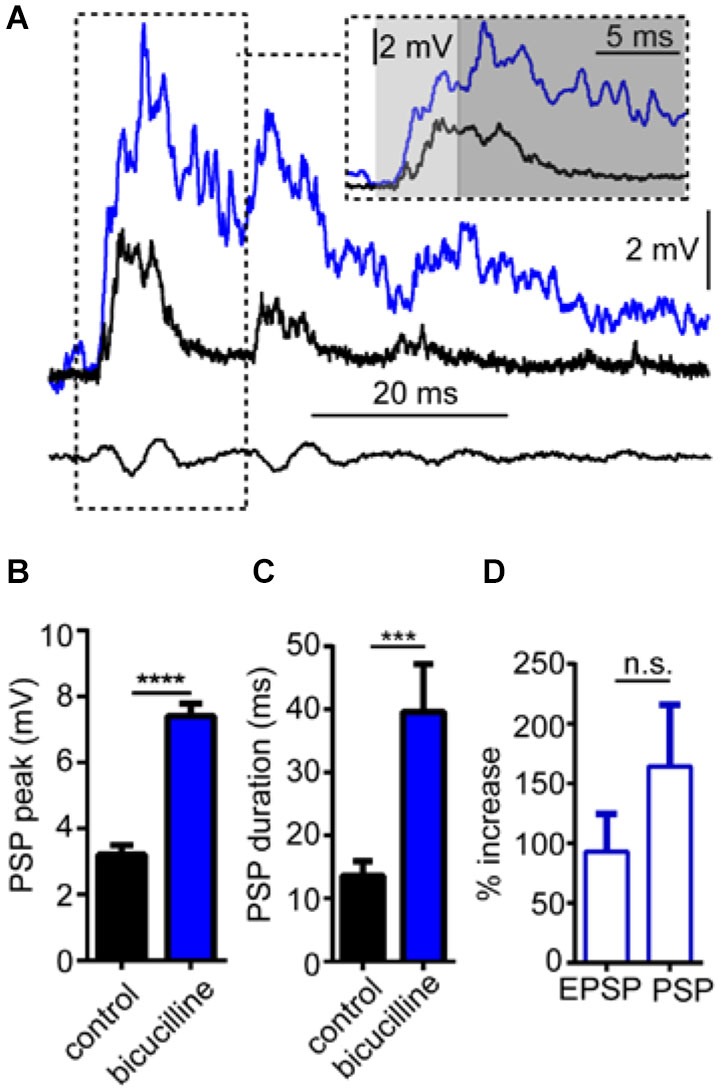
GABAARs mediate auditory processing. (A) Sample intracellular recordings from the Mauthner-cell (M-cell) soma in response to an individual sound pip before (black trace) and after (blue trace) treatment with the GABAAR antagonist bicuculline. The inset shows the initial part of the evoked response at an expanded time scale. Light and dark shaded areas distinguish the initial (EPSP; 0–5 ms) and later components (mixed PSP; >5 ms) of the response, respectively. Bottom traces show sound stimulus (200 Hz single-cycle “pip” at 80 dB re: 20 μPa). (B) Plots of mean (± SEM, N = 5) overall peak amplitude of sound-evoked depolarization in control (black bar) and bicuculline (blue bar) conditions. (C) Plots of mean (± SEM, N = 5) PSP duration (Tau) before (black) and after (blue) treatment with bicuculline. (D) Plots of the mean (± SEM, N = 5) relative change in sound-evoked depolarization for the initial (EPSP) and later parts (mixed PSP) of the sound response after treatment with strychnine. Asterisks indicate p values in statistical comparisons that were < 0.001 (***), < 0.0001 (****).